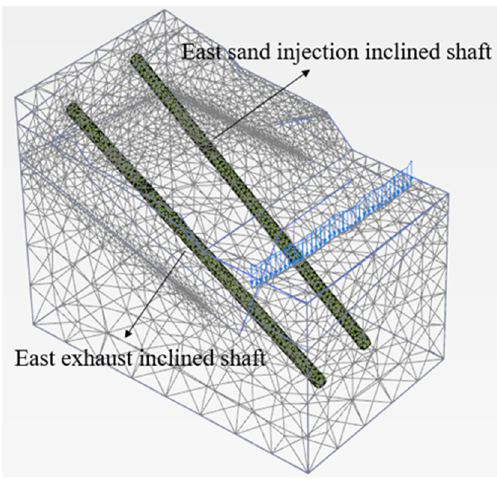
Figure 6. Schematic diagram of dynamic load and inclined shaft position.